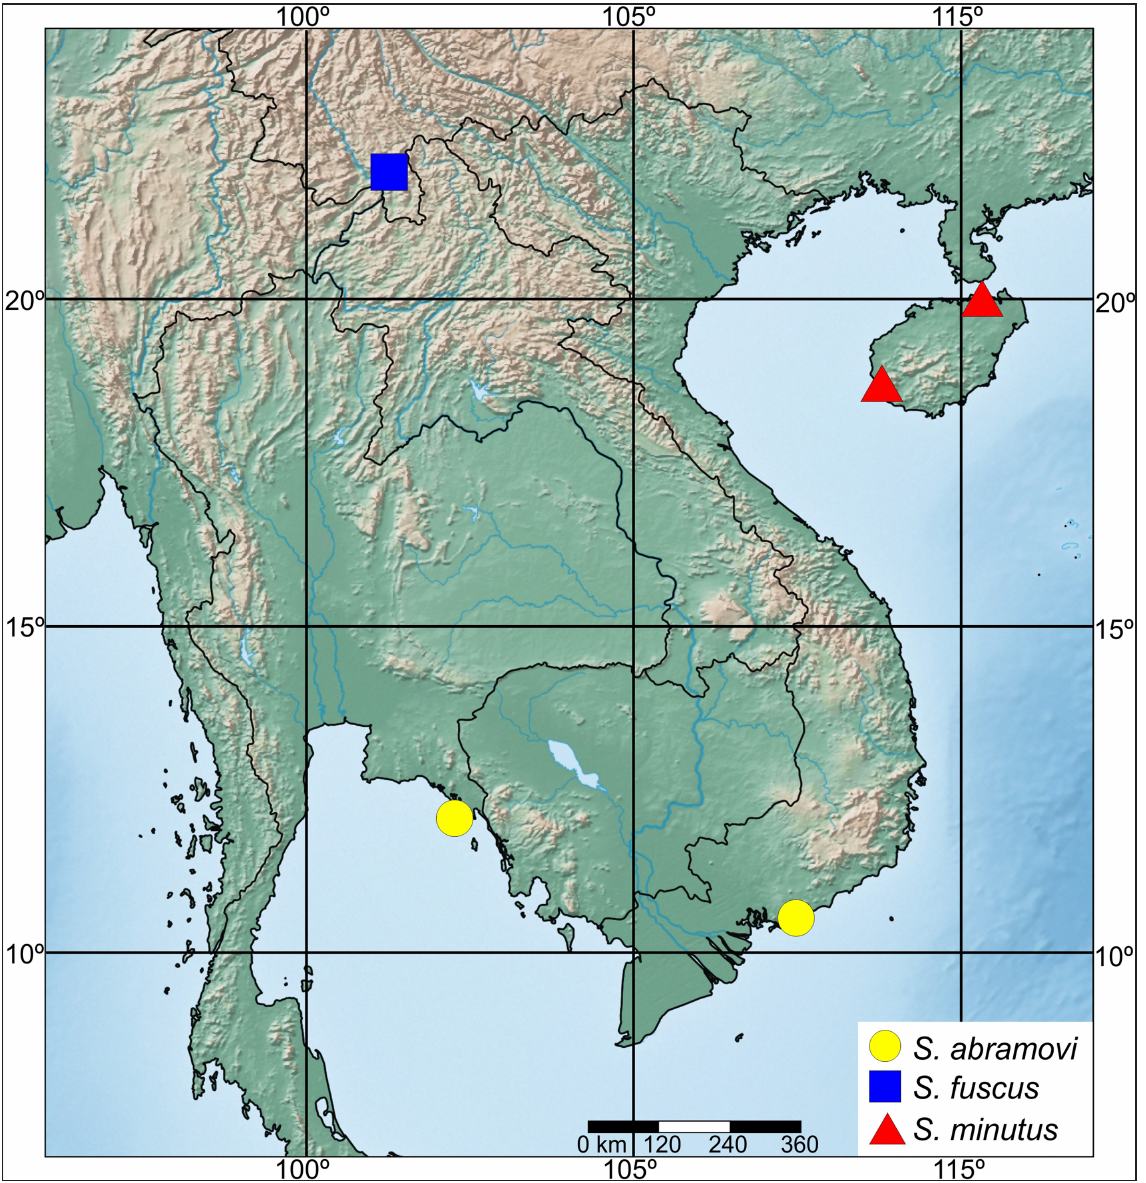
Fig. 508. Collecting localities of three Oriental species of Stenaelurillus Simon,